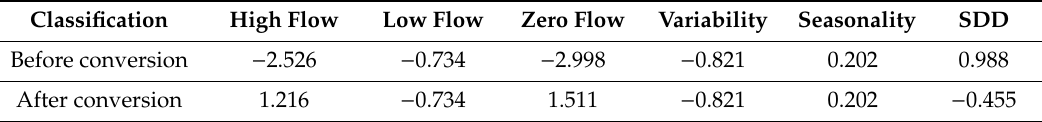
Table 8. Variation in the skewness of water quantity data based on the normality review.